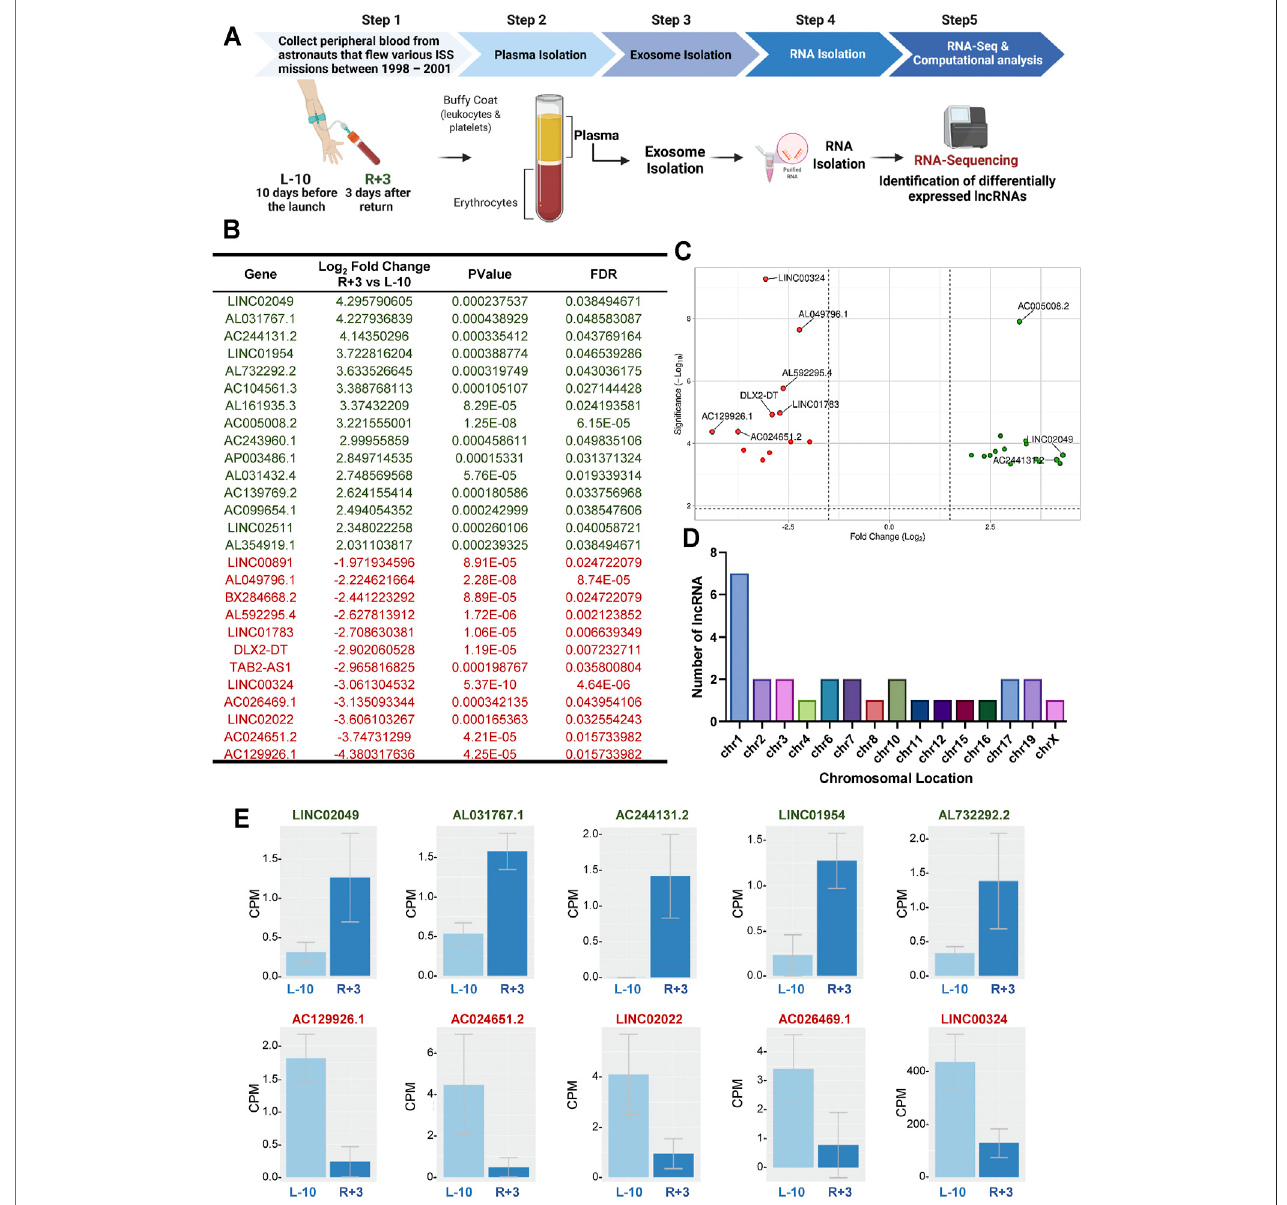
FIGURE1| Identi fi cation of27differentially regulatedlncRNA inexosomesfrom astronauts3-dayspost-landing. (A) Schematicrepresentation oftheexperimental design. Blood was sampled at two different time points: 10 days before launch (L-10) and 3 days after return (R+3) from three different astronauts. Exosomes were isolatedfrom blood plasma,and puri fi ed exosomal RNAwasanalyzedbyRNA-Sequencing. (B) Computational analysisidenti fi ed27differentially regulated lncRNA with a Log 2 fold change > 2, p < 0.001, and FDR < 0.05, compared to baseline L-10. (C) Volcano plots showing Log 2 -fold changes for the 27 differentially regulated lncRNA and the statistical signi fi cance of each gene calculated after DEG analysis. Red points indicate signi fi cantly down-regulated genes; green points indicate up- regulated genes. (D) Chromosomal location of the lncRNA is shown. (E) Normalized counts, or the number of reads that align to a particular feature after correcting for sequencing depth and transcriptome composition bias, are shown for the top 5 up-regulated and down-regulated lncRNA in astronauts at L-10 and R+3.